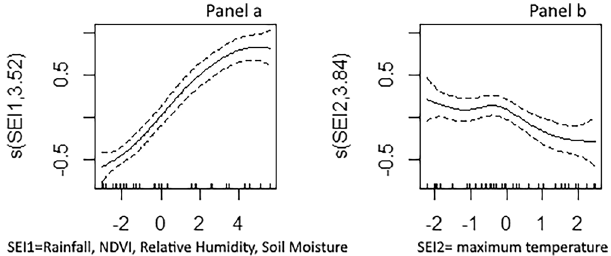
Figure 4. Changes in malaria incidence as a function of synthetic environmental indices; multivariate regression analysis using a Generalized Additive Model. ( Panel a ) Positive linear relationship between SEI 1 (rainfall, relative humidity, soil moisture, NDVI, and wind speed) and malaria incidence ( p value < 0.001). ( Panel b ) Negative non-linear relationship between SEI 2 (temperature) and malaria incidence ( p value < 0.01).